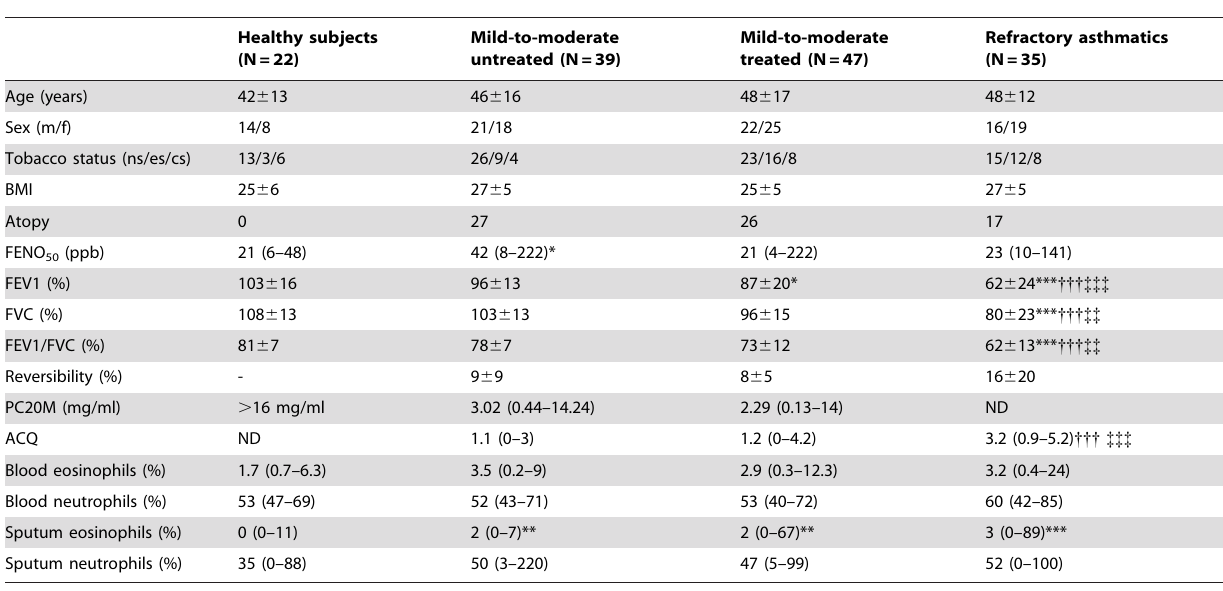
Table 5. Demographic, functional and airway inflammatory characteristics according to disease severity.